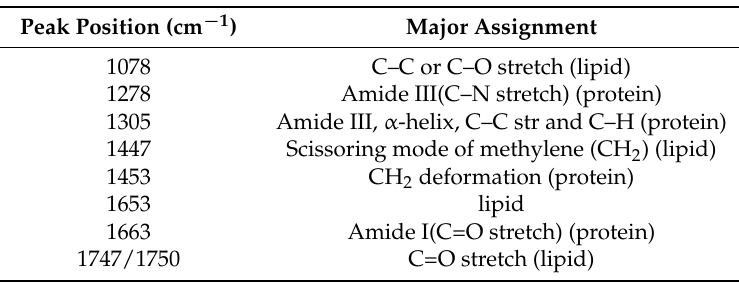
Table 1. Peak positions and assignments of breast tissue.